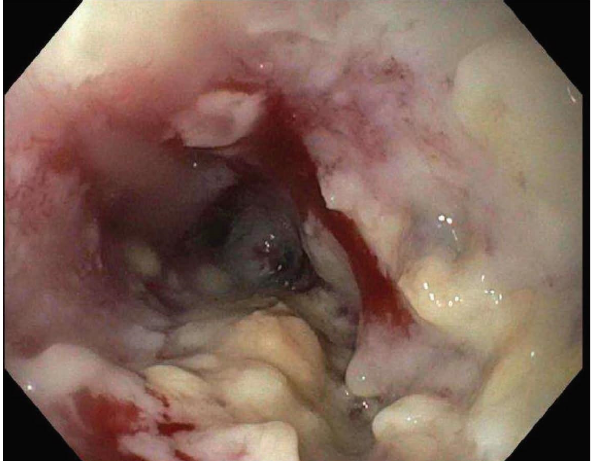
Figure 1: Large ulcerating mass in the middle third of the esophagus, 26cm from the incisors on the